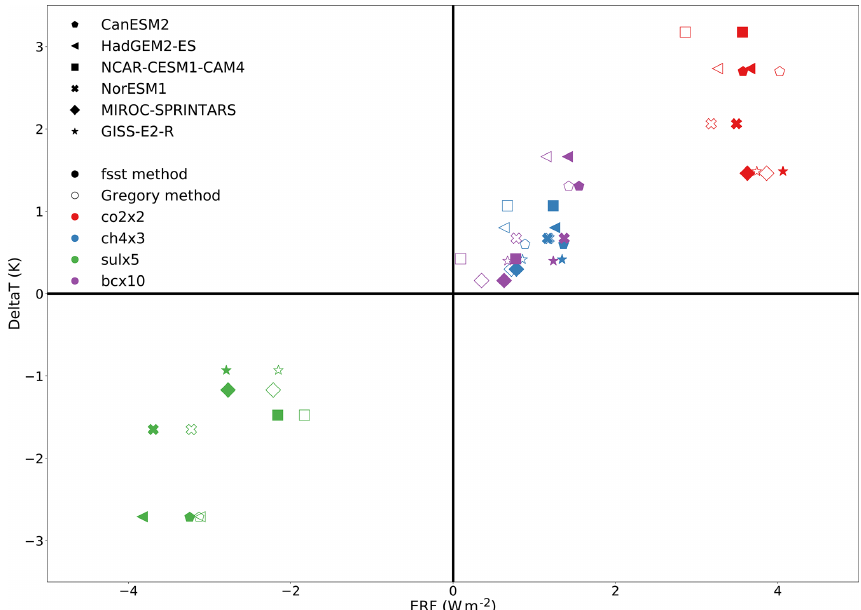
Figure 2. The global average temperature responses for each experiment and each model ( y axis) averaged over years 50–100 after the sudden introduction of climate perturbations. The calculated ERFs for each experiment and model are shown on the x axis, with non-filled marks indicating the ERF reg obtained using the Gregory method and the filled markers indicating ERF fsst obtained from fixed-sea-surface- temperature